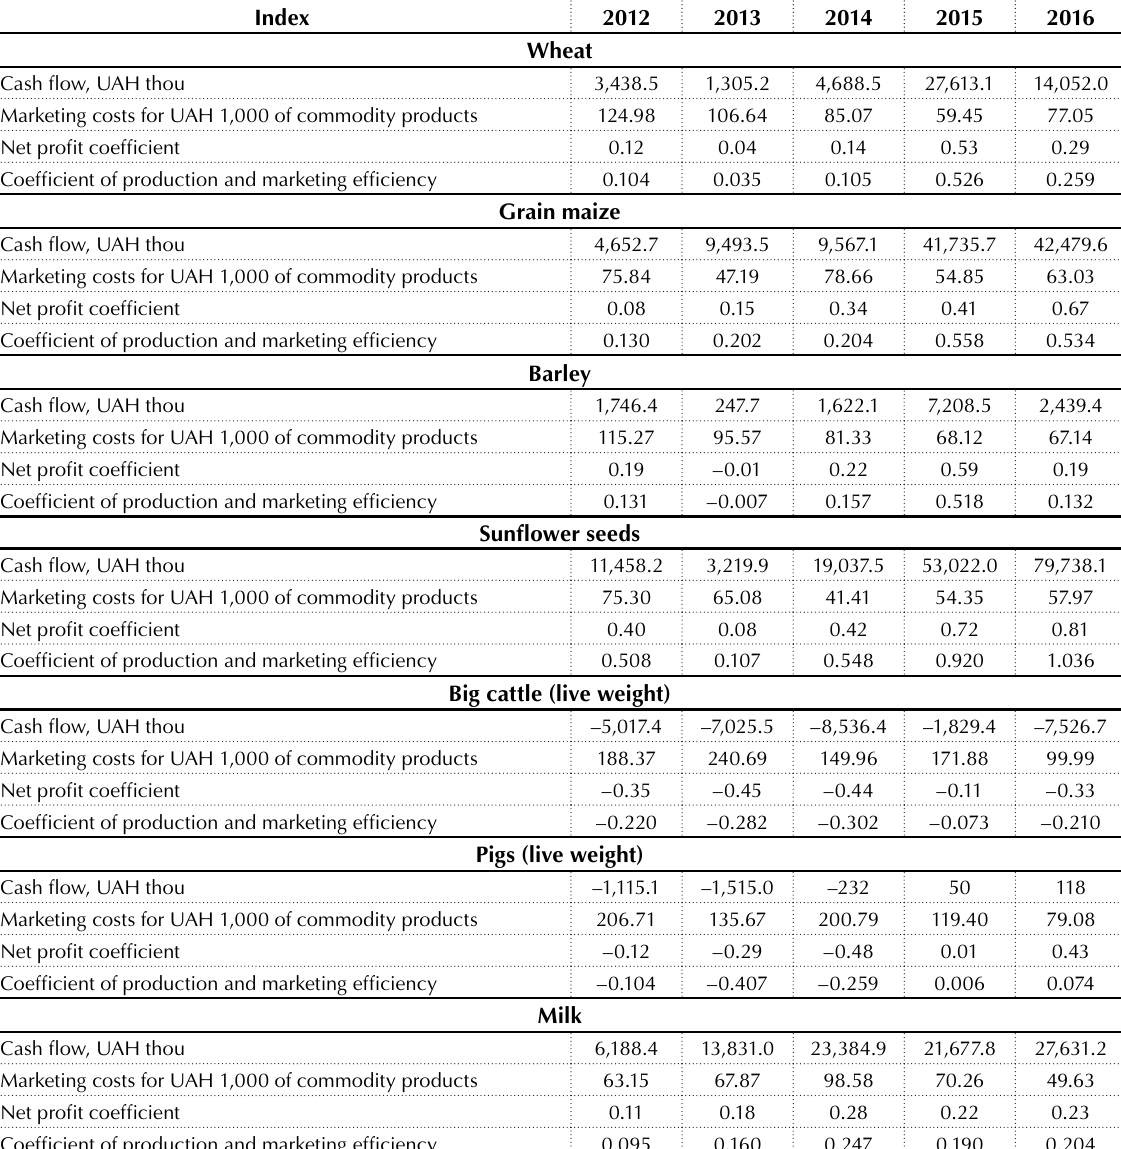
Table 11. Marketing performance of agricultural enterprises of Khrystynivka district, Cherkasy region in terms of products Source: Calculated according to the data of agricultural enterprises’